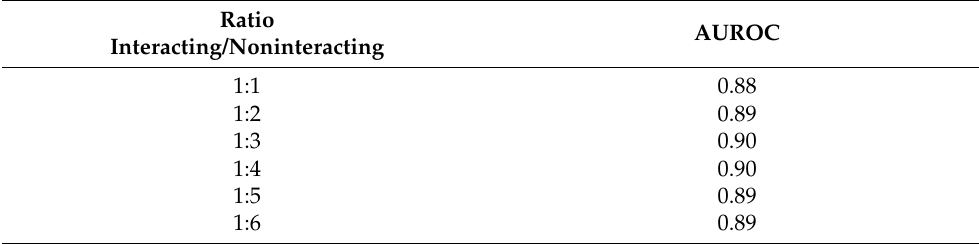
Table 3. Prediction performances based on different class